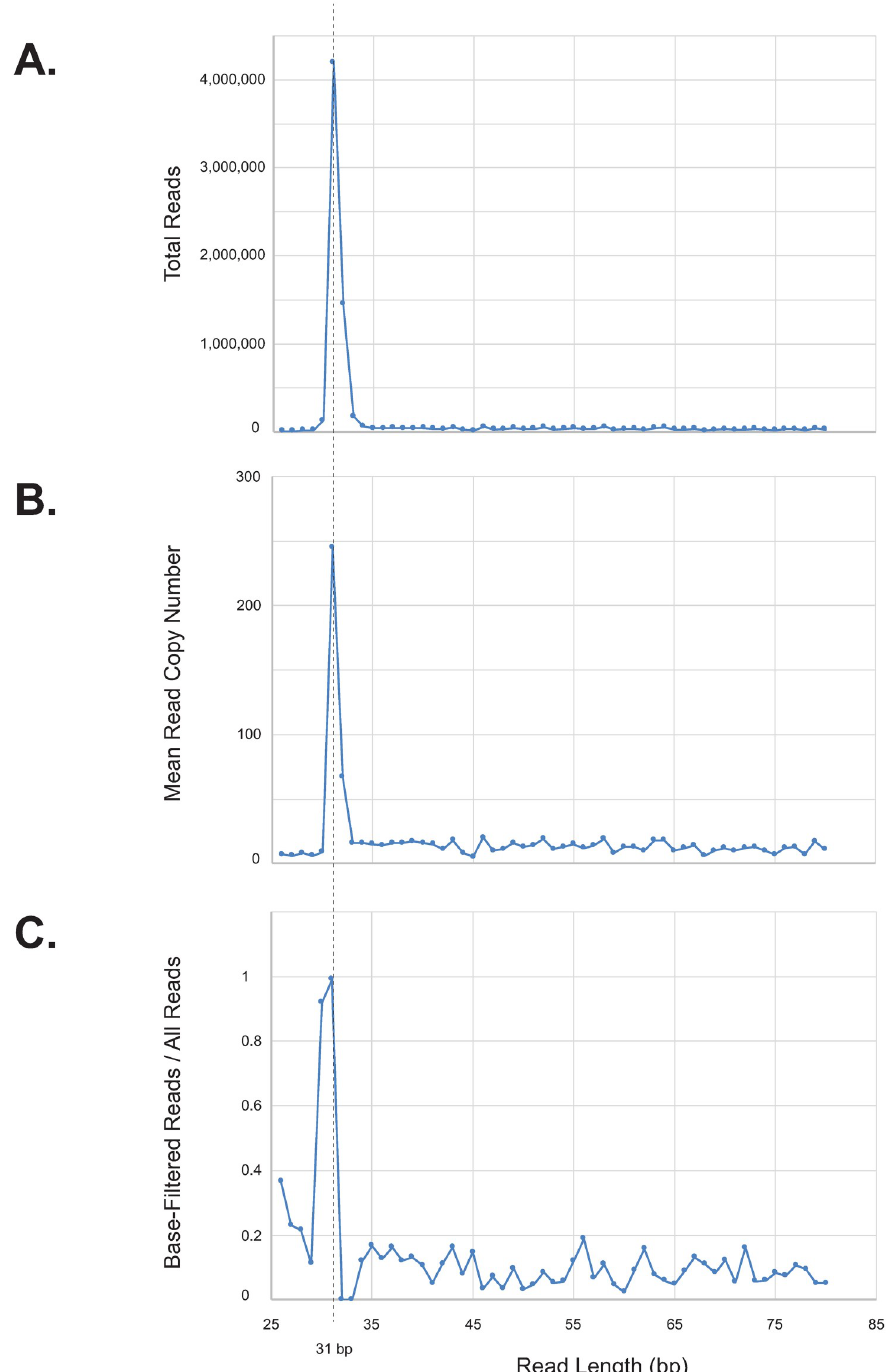
Fig 4. Diagnostic statistics from Illumina sequencing of FspEI-digested E . coli K-12 DHB4. This strain is methylated by Dcm at CCWGG sites, resulting in 31 nt CCMD reads (dotted vertical line). All numbers are for reference-matched reads. (A) Total number of reads of each length. (B) Mean read copy number of each length. (C) Fraction of reads of each length that passed base filtering.